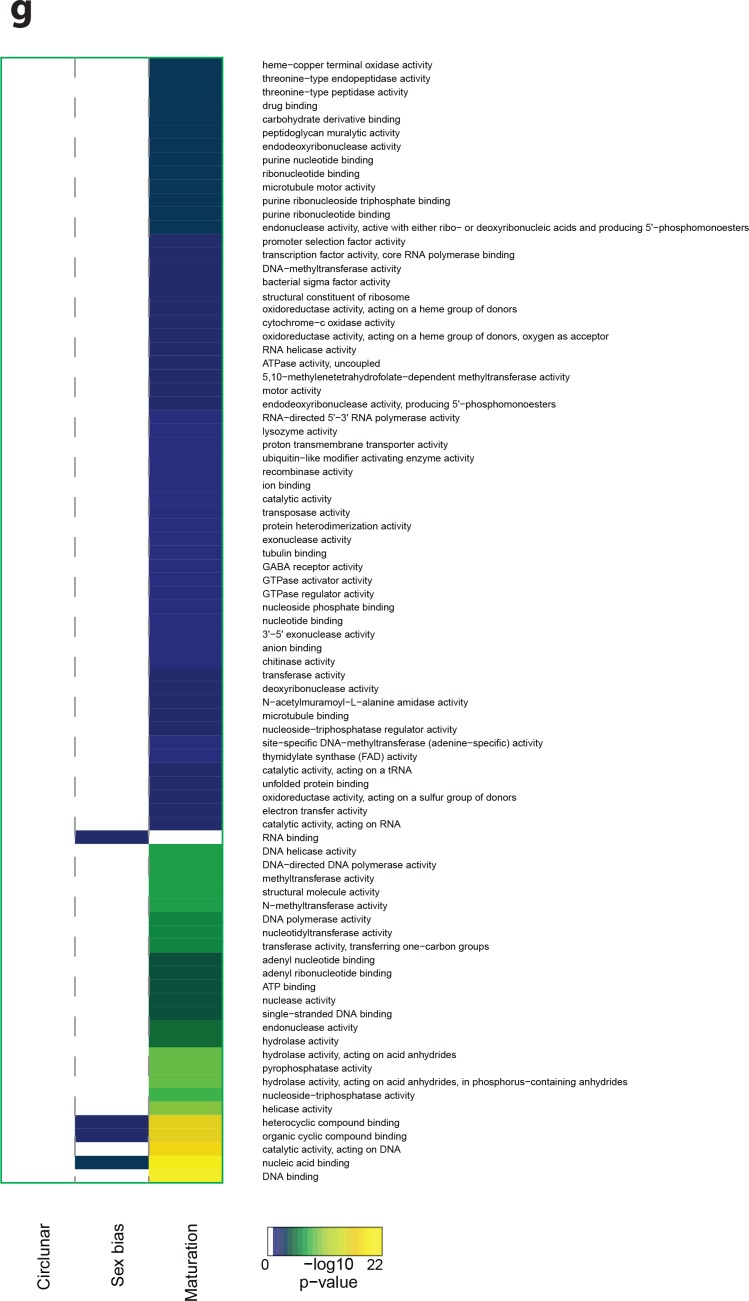
Heat map displaying under-represented GO-terms in the Molecular Function category.The heat map is subdivided (columns) by the regulation of each GO-term by circalunar clock phase (left), sex (middle) and/or maturation (right); colours are indicative of the enrichment p-value as calculated by a hypergeometric test implemented in the GOStats package.